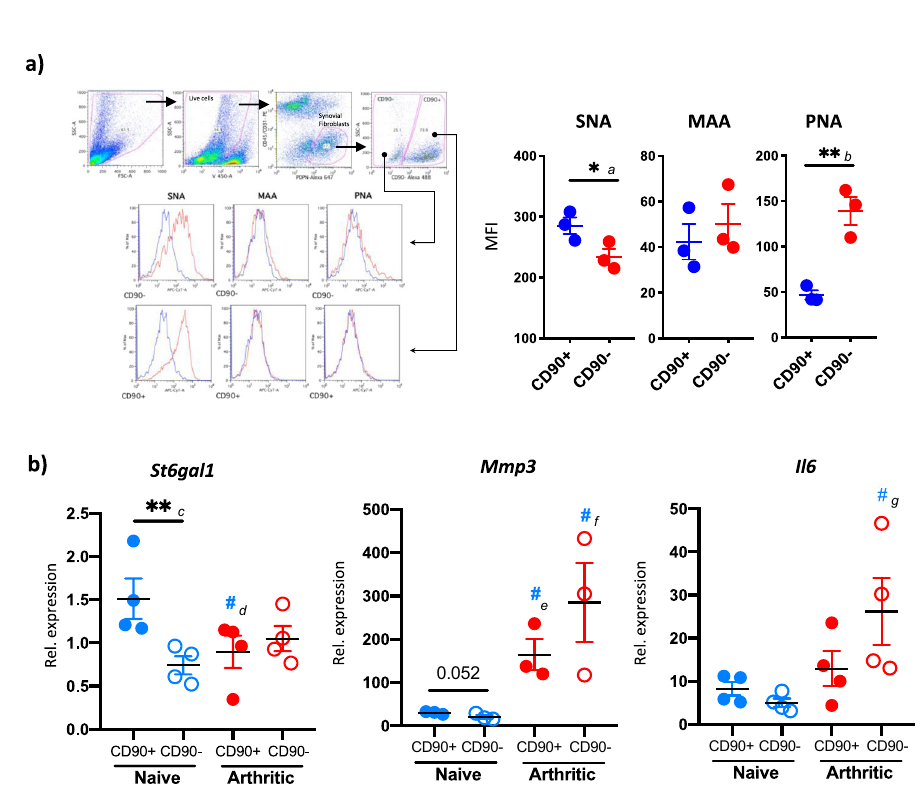
Fig. 5 TNF inhibits St6gal1 expression to down-regulate α 2-6-sialylation in synovial fi broblasts. a Illustration shows pathways involved in sialic acid and sialylated glycans biosynthesis. Relative expression for each gene was extracted from bulk RNA-Seq data comparing naive and arthritic SFs directly isolated from mouse synovium. b Synovial fi broblasts expanded from healthy or arthritic mouse joints were stimulated in vitro for 6 h with recombinant IL-1 β , TNF, or IL-17A [10 ng/ml]. mRNA expression for genes involved in sialylation [as shown in a ] was evaluated by RT-qPCR. Il6 was included as a positive control to con fi rm cell activation. Volcano plots show log2 fold difference in stimulated cells ( x axis) and p -value ( y axis). Each dot represents the mean of three independent experiments analyzed in triplicate, with naive cells in blue and arthritic cells in red. The pink line indicates a twofold-change in gene expression threshold and blue lines indicate p = 0.05 threshold in the t -test to evaluate statistical signi fi cance. c TNF, but not IL-1 β or IL-17A reduces α 2-6-sialylation of synovial fi broblasts both at RNA ( St6gal1 expression) and protein (SNA binding) levels. Expression of St6gal1 (left panel ) was evaluated by RT-qPCR. Results show the mean of three independent experiments analyzed in triplicate, error bars represent SEM. Statistical signi fi cance was determined using two-tail unpaired t -tests where * p < 0.05 and ** p < 0.01. Actual p -values: a 0.0069, b 0.0277. Expression of α 2-6 sialylated glycoconjugates was determined by SNA binding (right panel) as in Fig. 4a. Results are merged from 3 (naive) and 2 (CIA) independent experiments, n = 10 (DMEM naive), 16 (IL-1 naive and IL-17 naive), 13 (TNF naive), 10 (DMEM CIA), 12 (IL-1 naive and IL-17 naive), and 9 (TNF CIA). Statistical signi fi cance was determined using two-tail unpaired t -tests, where ** p < 0.01 and *** p < 0.001. Actual p -values: c 0.0124, d 0.0091. d SFs were expanded from OA human synovium. Cells were stimulated with recombinant human TNF (10 ng/ml) for 6 h. IL6 , ST6GAL1, and ST6GAL2 expression were determined by qPCR. Results show relative expression to HPRT, showing mean ± SEM. Statistics: one-tail unpaired t -test, n = 3 biological replicates from cells pooled from three donors, MALDI-TOF MS analysis as in Fig. 3. Ratios of sialylated vs non-sialylated twin structures were evaluated for non-stimulated cells (blue) and TNF